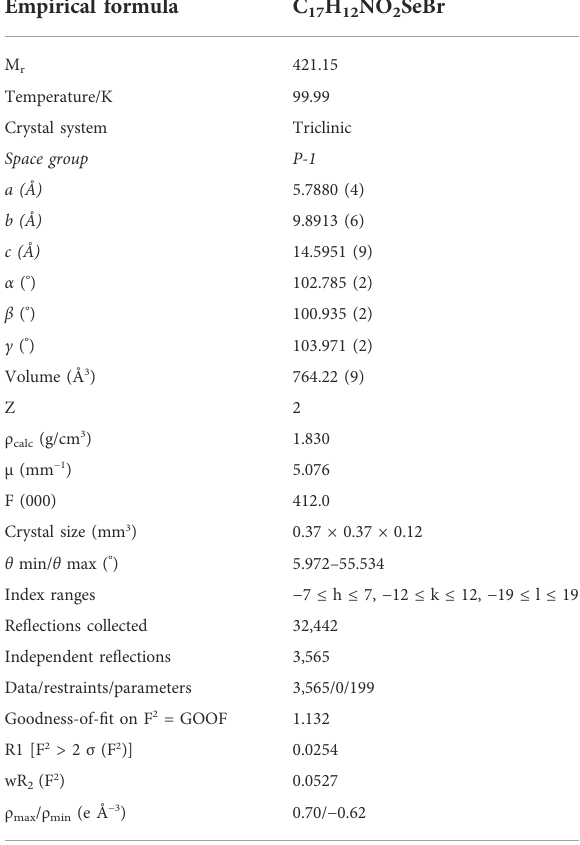
TABLE 1 Crystal data and structure re fi nement for compound 4. Empirical